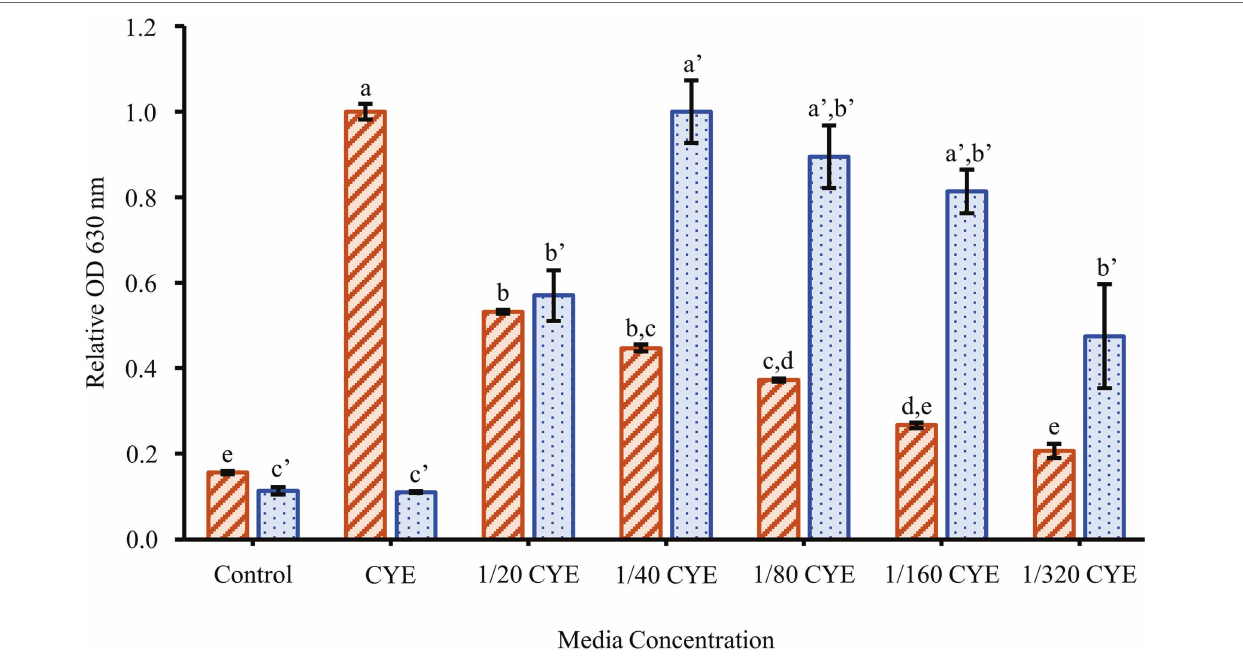
FIGURE 1 | Effect of media concentration on biofilm formation. The planktonic growth (orange-striped bars) and biofilm formation (blue-dotted bars) of Flavobacterium johnsoniae wild type grown for 24 h in a series of dilutions of casitone-yeast extract (CYE) media. Results are reported as relative optical density (OD) values (averages of at least four replicates; normalized to highest average in dataset). Error bars indicate 95% CI. Different letters above the error bars represent different significance groups among growth and biofilm measurements (one-way ANOVA followed by Tukey test, value of p = 0.05).